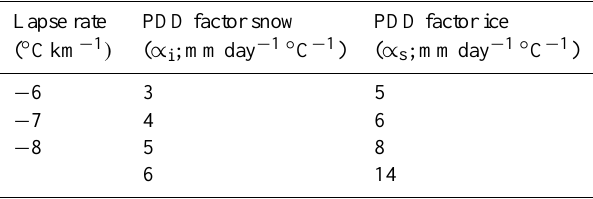
Table 2. The three glaciological parameters and the values consid- ered in the ice sheet modelling simulations. By varying each glacio- logical parameter independently, while holding the others constant, there are a total of 48 sensitivity experiments performed for each ice sheet model